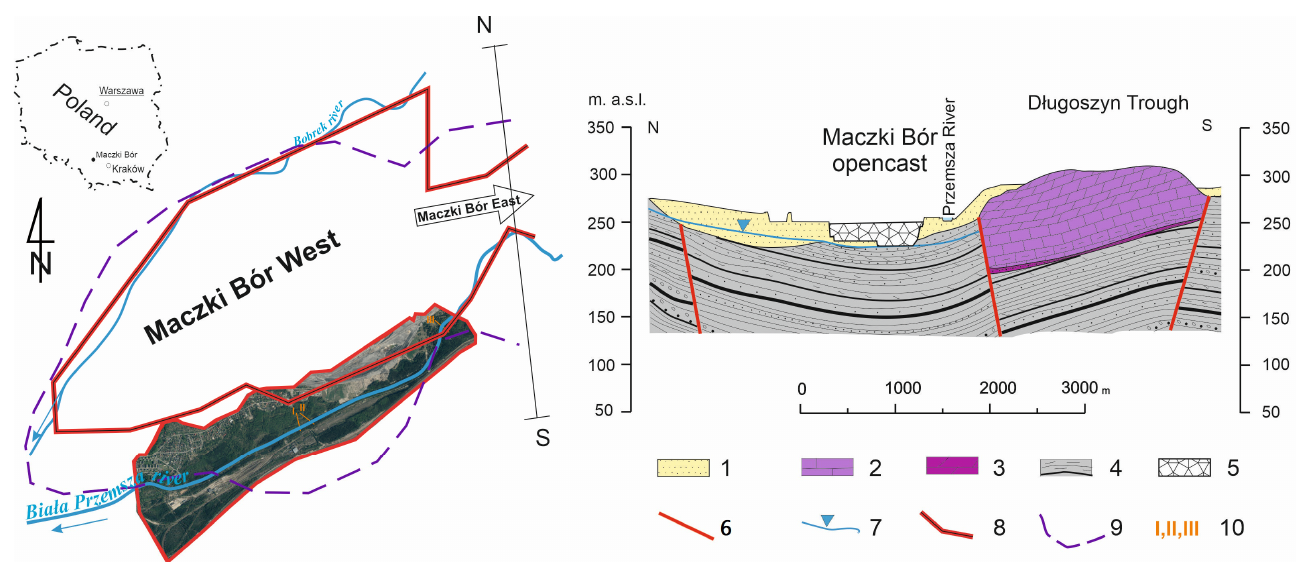
Figure 2. Location of the former Maczki Bór opencast and geological cross-section: 1—Pleistocene sands, 2—Middle Triassic, 3—Lover Triasic, 4—Upper Carboniferous with coal beds, 5—waste from coal mines, 6—fault, 7—groundwater level, 8—boundary of sand deposit, 9—boundary of the mining area, 10—transect numbers in the study area.